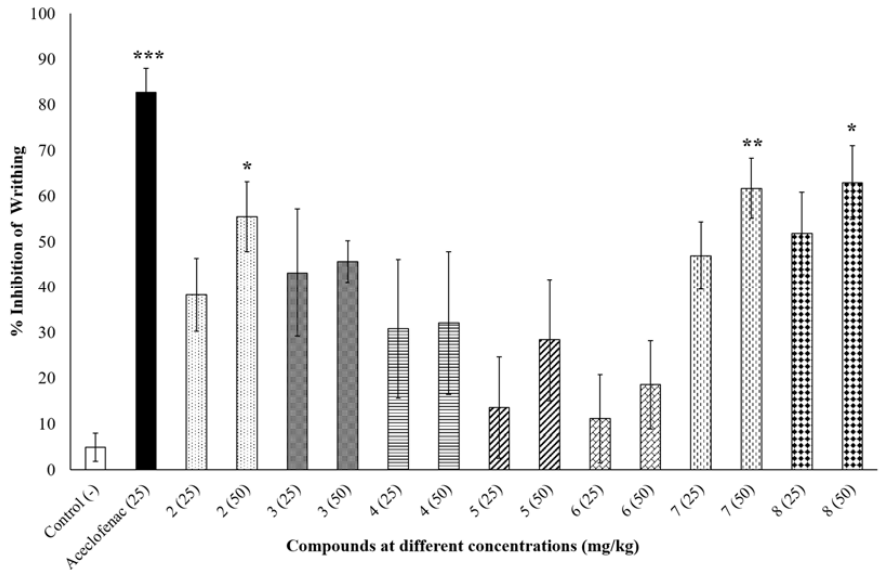
Figure 1. Percent inhibition of writhing at different concentrations (mg/kg) of tested compounds. * p < 0.05, ** p < 0.01 and *** p < 0.001 indicate significant difference compared to negative control (0.9% NaCl saline).